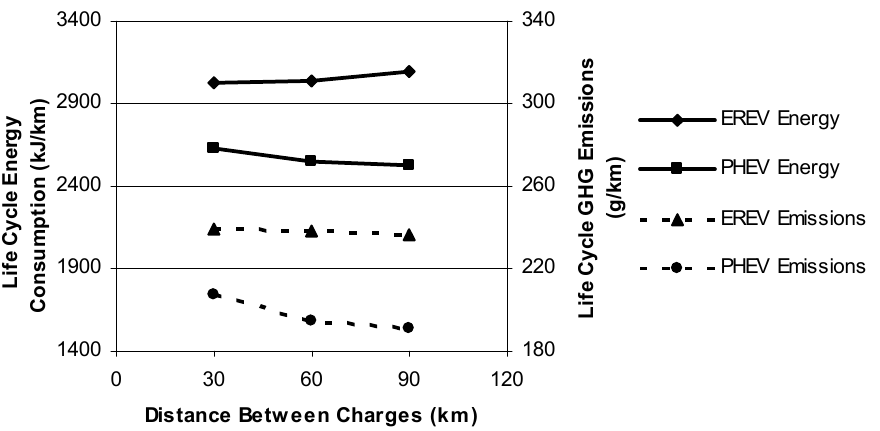
Figure 5. Lifetime energy consumptions and emissions of the two PHEVs as a function of the distance driven between